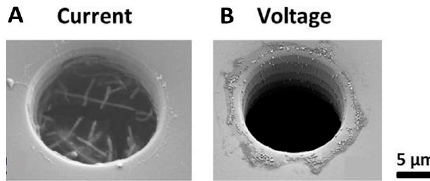
Figure 6. Di ff erent morphologies for gold deposition according to ( A ) current or ( B ) voltage applications in the CLEF protocol.